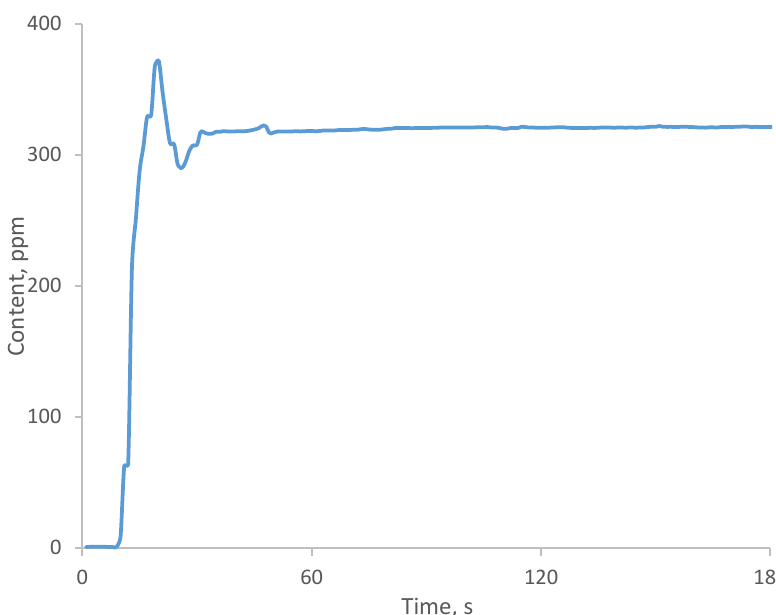
Figure 10. Change of CO content, sample 2, MC of − 1.13 mm.